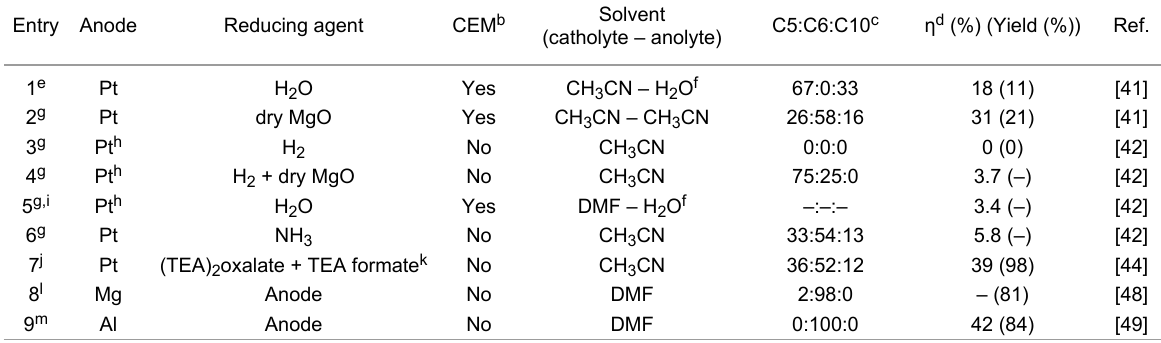
Table 1: Electrocarboxylation of 1,3-butadiene in different setups. a